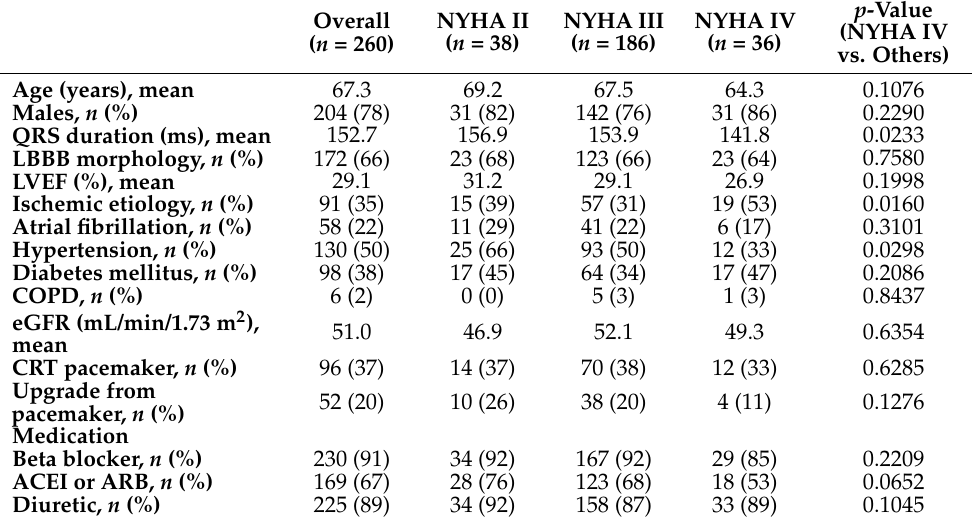
Table 1. Baseline characteristics and